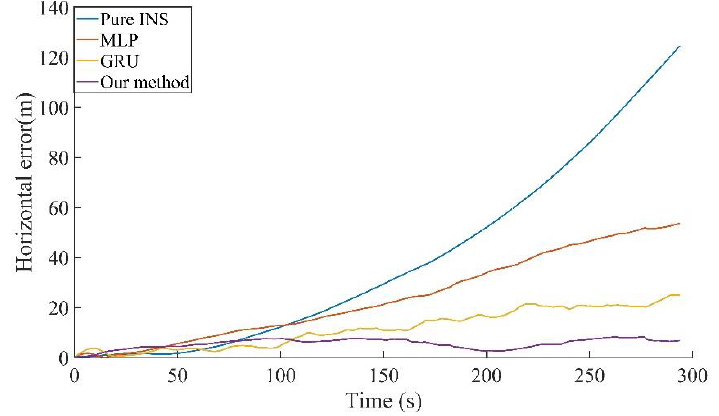
Figure 17. The north position error result of 300 s outage of Experiment 1.